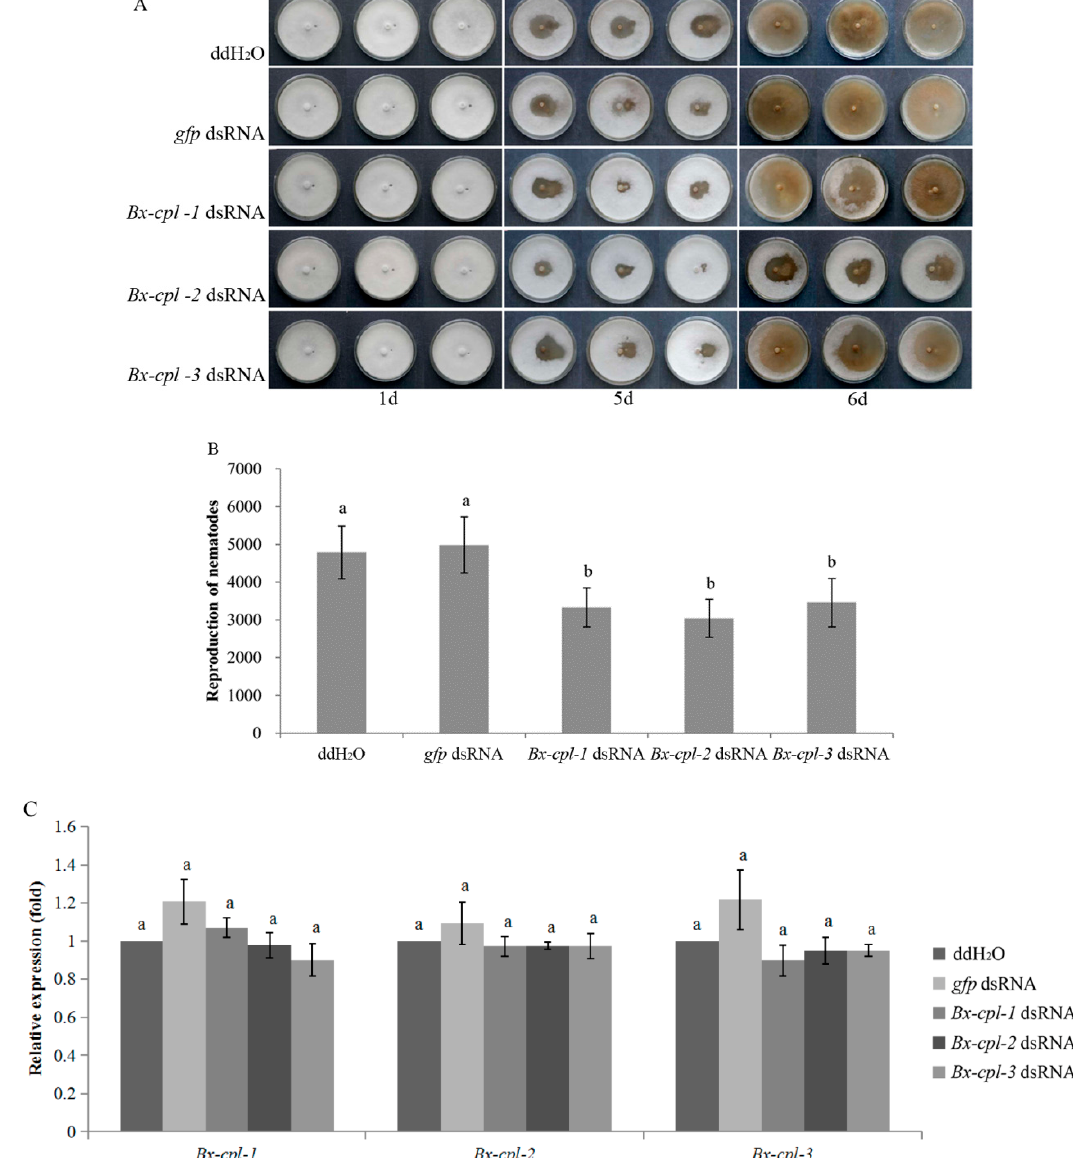
Figure 7. Effects of RNA interference (RNAi) on feeding and reproduction of B. xylophilus . RNAi-treated B. xylophilus after cultivation on B. cinerea ( A ); Total B. xylophilus population recovered from B. cinerea plates six days after treatment with ddH 2 O and dsRNA ( gfp , Bx-cpl-1 , Bx-cpl-2 , and Bx-cpl-3 ) ( B ); Relative expression levels of Bx-cpl s after cultivation on B. cinerea for six days ( C ).